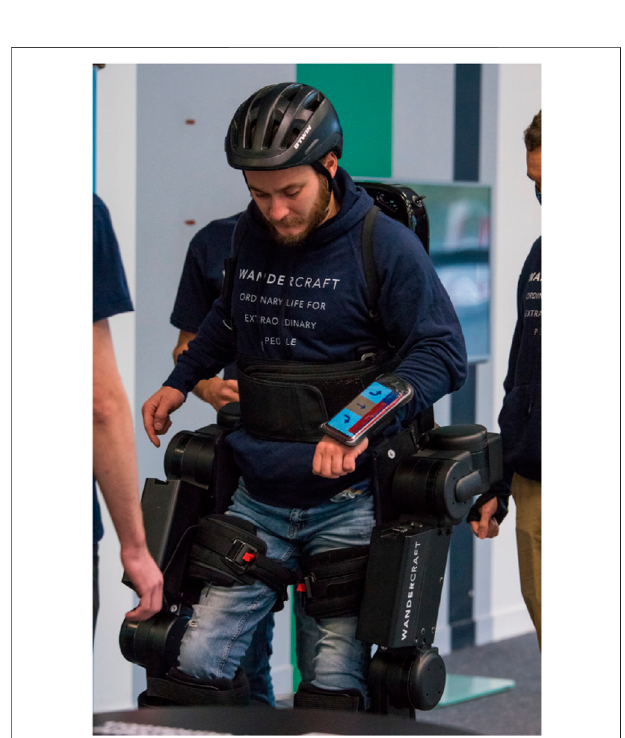
FIGURE 6 | Atalante Evolution ’ s control architecture overview schema.